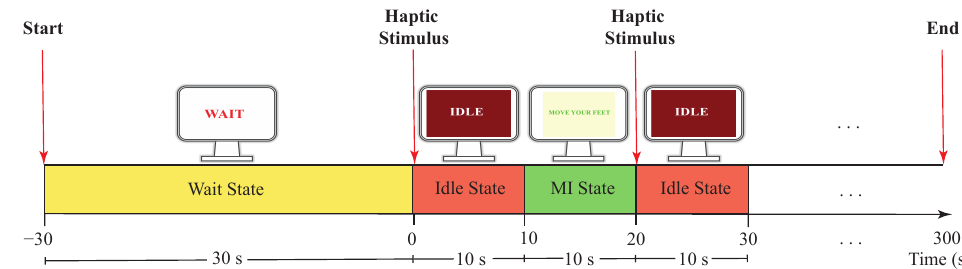
Figure 3. Timeline strategy applied in MI experimental conditions with visual and haptic stimulus. The Idle and MI states repeated alternately until fulfilling the 5-min test.